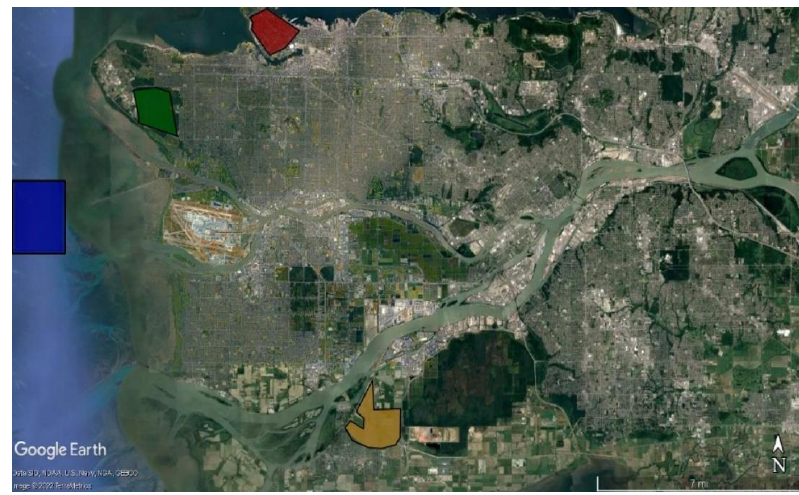
Figure 1. Intensities of HV, HH, VH and VV channels of PolSAR SLC data depicting the broader area of Vancouver, before and after preprocessing (radiometric calibration and geometric correction).